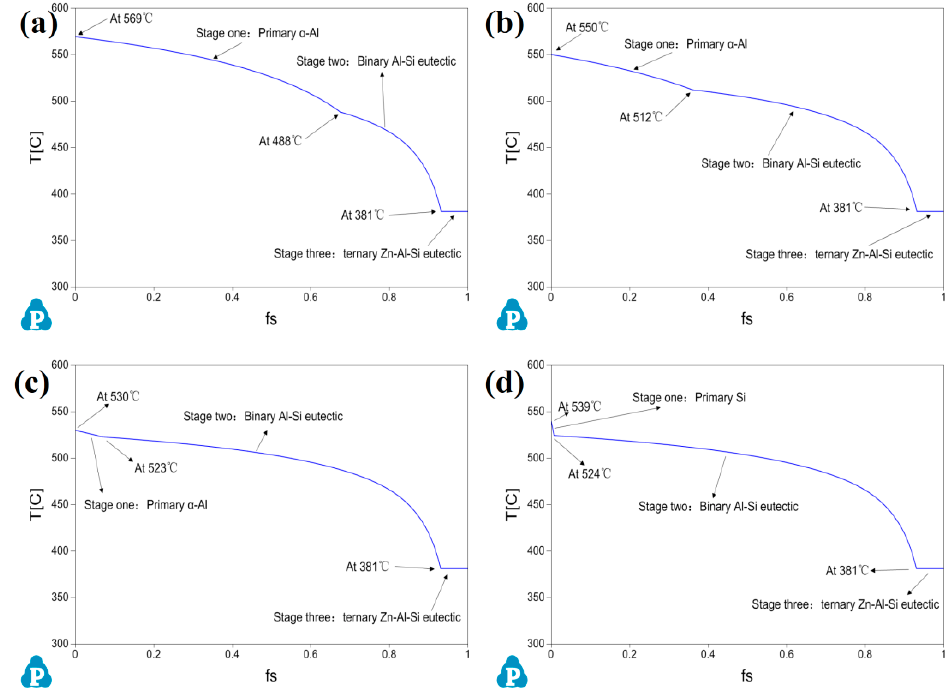
Figure 3. Change in solid-phase fraction in Al-40Zn-xSi gold with temperature during non-equilibrium solidification calculated by Pandat software: ( a ) Al-40Zn-1Si, ( b ) Al-40Zn-3Si, ( c ) Al-40Zn-5Si, ( d ) Al-40Zn-6Si.